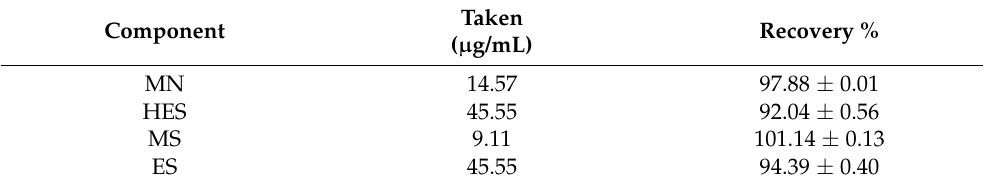
Table 4. Analysis of MN, HES, MS and ES in Deep Heat Spray by the proposed HPLC method. Component